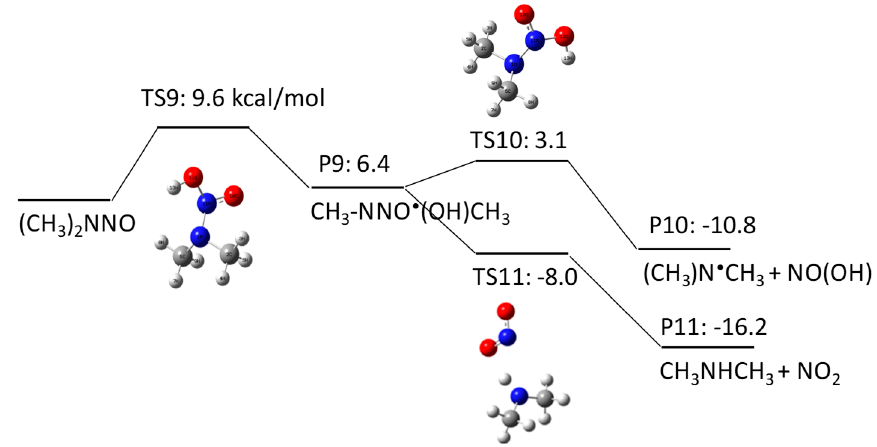
Figure 3. Free energy profile for pathway 1–3 of the HO • -induced reaction pathways for N -nitrosodimethylamine (NDMA) via HO • addition to the nitrosyl nitrogen. The numbers (kcal/mol) are the free energy of activation for the TS and free energy of reaction for the P relative to the corresponding reactant.